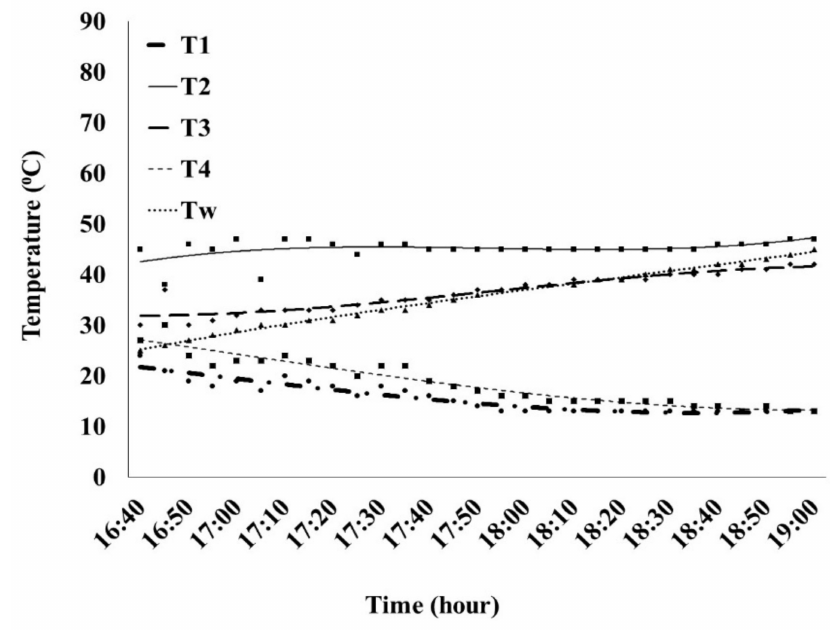
Figure 15. Variation of temperatures at different locations with